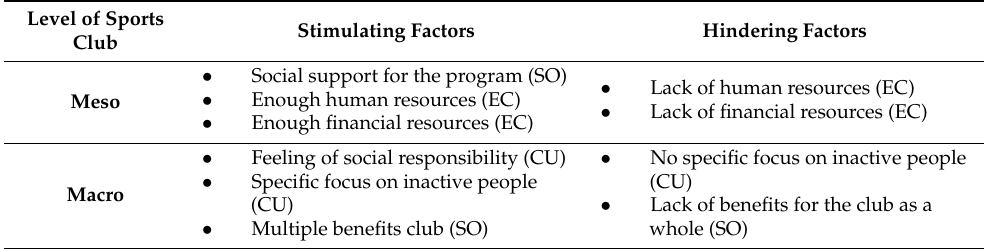
Table 5. Stimulating and hindering factors to involve the meso- and macro-level of the sports club in the